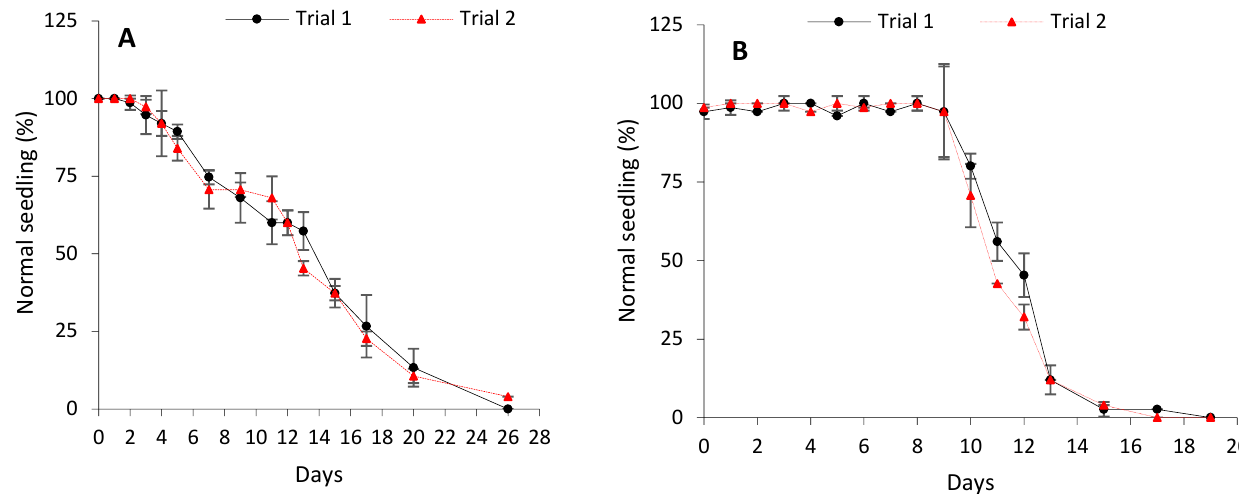
Figure 1. Controlled deterioration curves for cabbage ( B. oleracea ) ( A ) and lettuce ( L. sativa ) ( B ). Data points represent mean ± SD (4 × n = 25). The experiment was repeated twice for both species. Table 1. Rate of deterioration in cabbage and lettuce seeds subjected to controlled deterioration (CD).